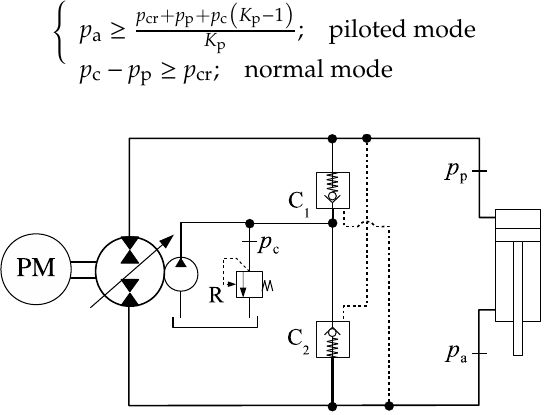
Figure 13. Pressures within the circuit using pilot-operated check valves.